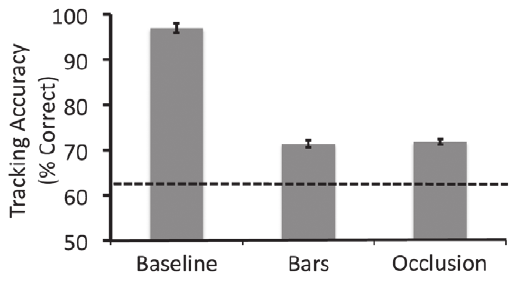
Figure 5. Results from Experiment 3.